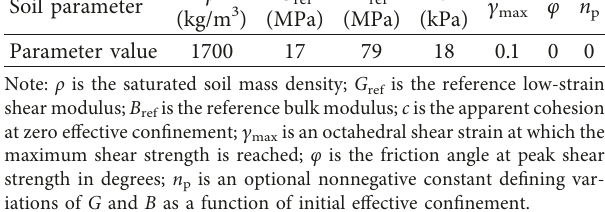
c and λ vs c curves. max vs